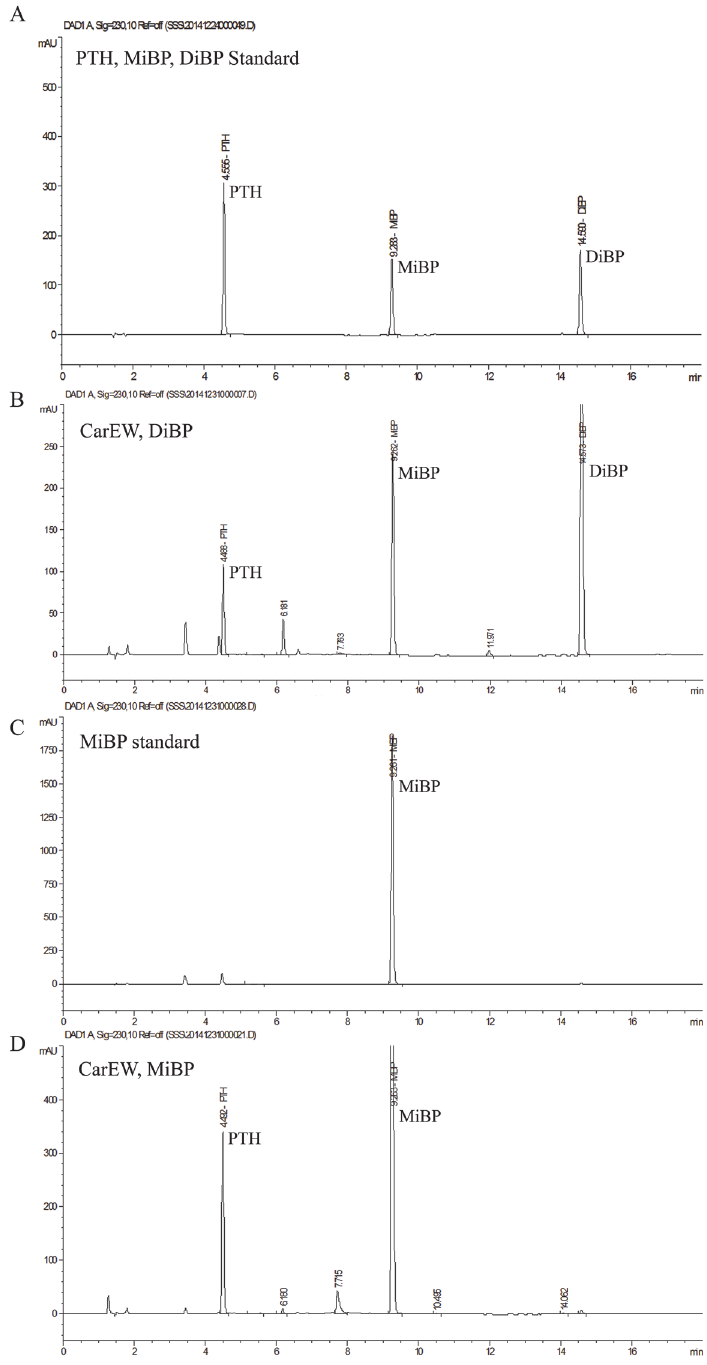
Fig 6. The results of HPLC analyses of catabolic intermediates. (A) DiBP, MiBP and PTH mixture for the standard sample. (B) The results of DiBP degradation after incubation with CarEW. (C) Reaction of MiBP